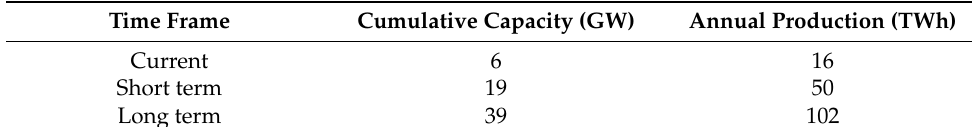
Table 1. Estimated wind power capacities in the Bothnian Bay region.